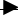
Fig. 7a (cid:177) c. Current vectors in the discharge region of Hellespont derived from the MCC method and NOAA-11 AVHRR, 1993; a between 27 June, 1300 GMT and 29 June, 1345 GMT; b between 29 June, 1345 GMT and 02 July, 1309 GMT; c between 02 July, 1309 GMT and 04 July, 1424